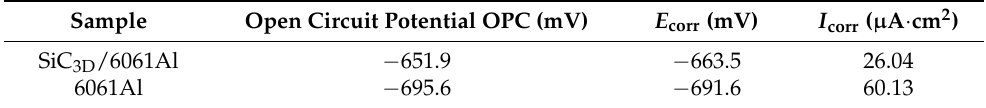
Table 2. Corrosion potential and corrosion